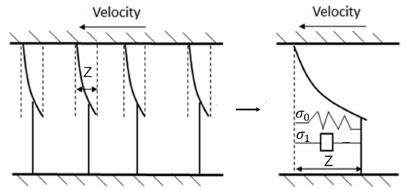
Figure 5. LuGre friction